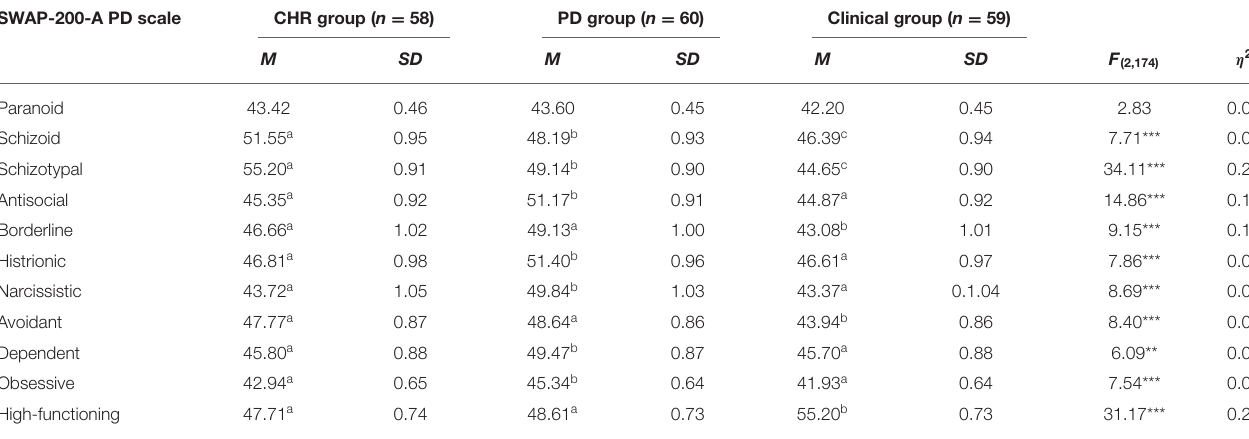
TABLE 1 | Differences between CHR, PD, and clinical adolescent groups on SWAP-200-A PDs and global psychological functioning ( N = 177). SWAP-200-A PD scale